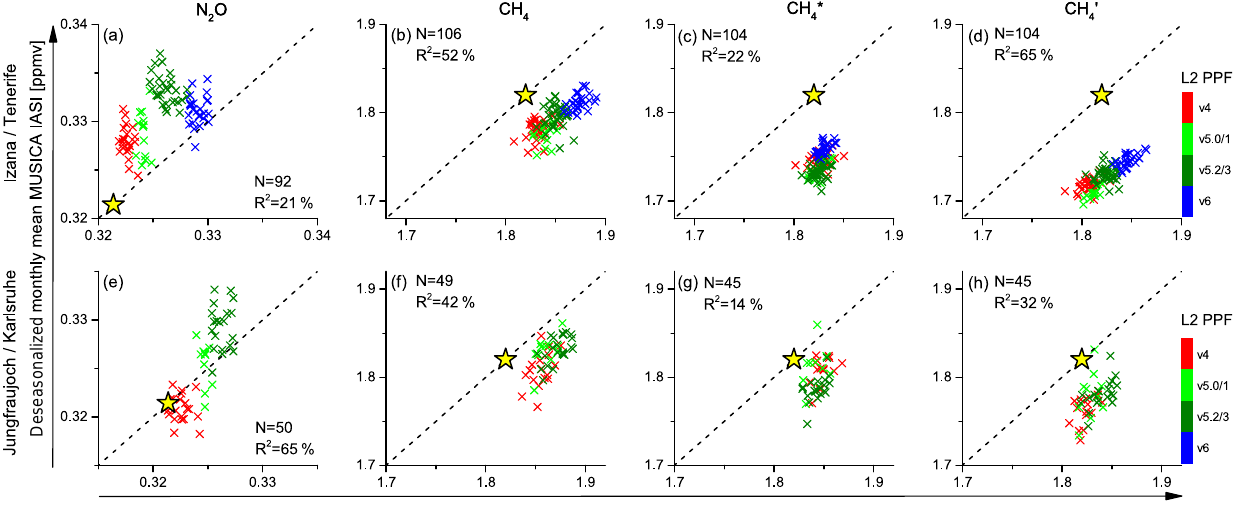
Figure 16. Correlation plots for deseasonalized monthly mean data (MUSICA IASI 4.2km retrieval products versus GAW high-mountain observatory in situ data): (a–d) for the surroundings of Tenerife Island; (e–h) for the surroundings of Karlsruhe; (a) and (e) for N 2 O; (b) and (f) for CH 4 ; (c) and (g) for CH ∗ ; and (d) and (h) for CH (cid:48) . A description of the CH ∗ and CH (cid:48) products is given in Table 2. The colour 4 4 4 4 code indicates periods with the different EUMETSAT L2 PPF software versions according to Table 1, the yellow star represents the a priori data used for the retrievals and the black dashed line is the one-to-one diagonal. Number of considered months ( N ) and R 2 values are given in each panel (all correlations are positive and significant on the 95% confidence